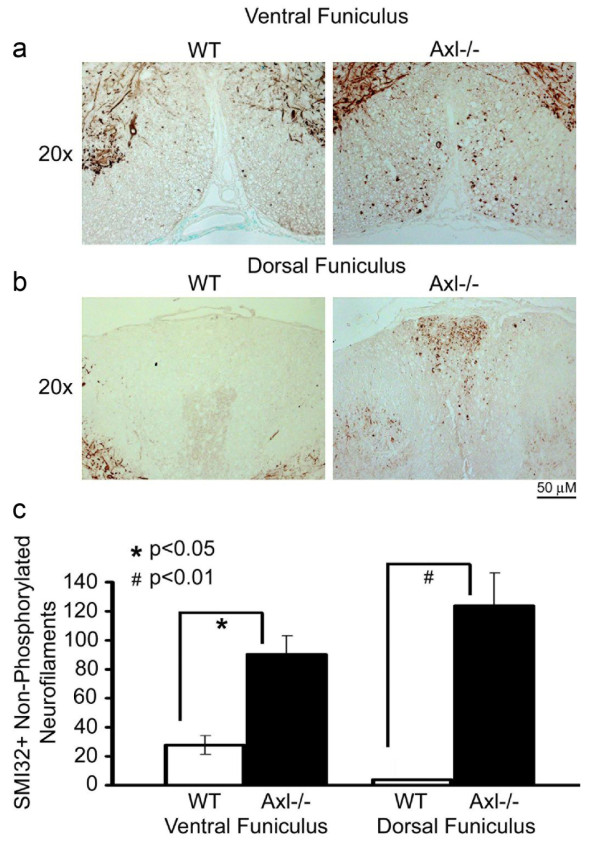
The spinal cord of Axl-/- mice has more axonal damage in the ventral and dorsal funiculi than WT mice. Seven micron paraffin-embedded WT and Axl-/- spinal cord sections were stained with SMI32, a mAb for non-phosphorylated neurofilaments. Representative 20× images are shown for the ventral and dorsal funiculi of WT and Axl-/- mice. b) SMI32+ non-phosphorylated neurofilament deposits were counted in the ventral and dorsal funiculi of three WT and three Axl-/- mice. Three or four sections were counted for each mouse and averaged. A student's t-test was performed to test significance; * = p < 0.05, # = p < 0.01.